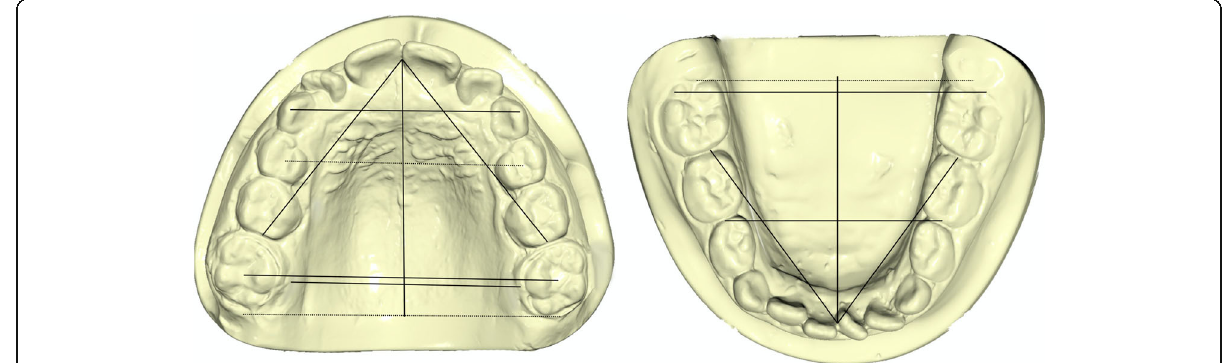
Fig. 2 Transversal and sagittal linear measurements performed at pre-treatment and post-treatment phase on upper and lower digital